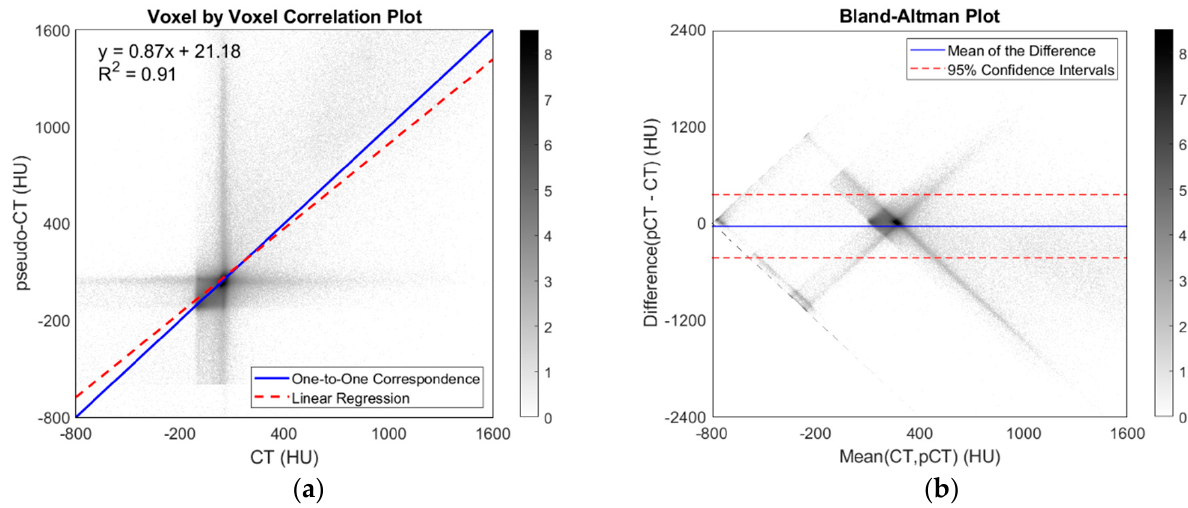
Figure 10. Voxel-by-voxel correlation plot between CT and pseudo-CT of each dataset evaluation image, expressed in Hounsfield Units (HU) ( a ) and Bland–Altman plot between CT and pseudo-CT for all validation subjects ( b ). Gray scale bars show density of voxels in histogram grid. Axis representation is focused on values in the range of human tissues, from lungs to cortical bone.